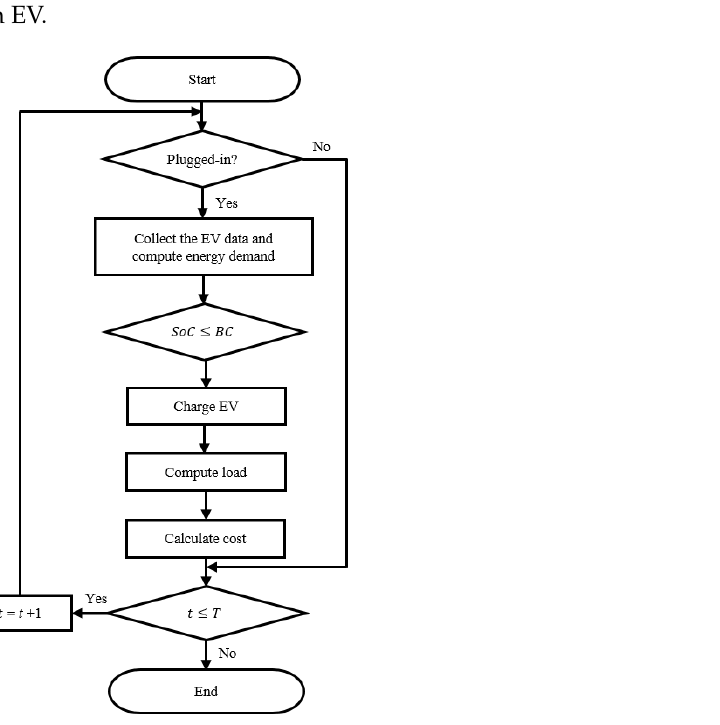
Figure 1. Flowchart of uncoordinated charging of electric vehicles